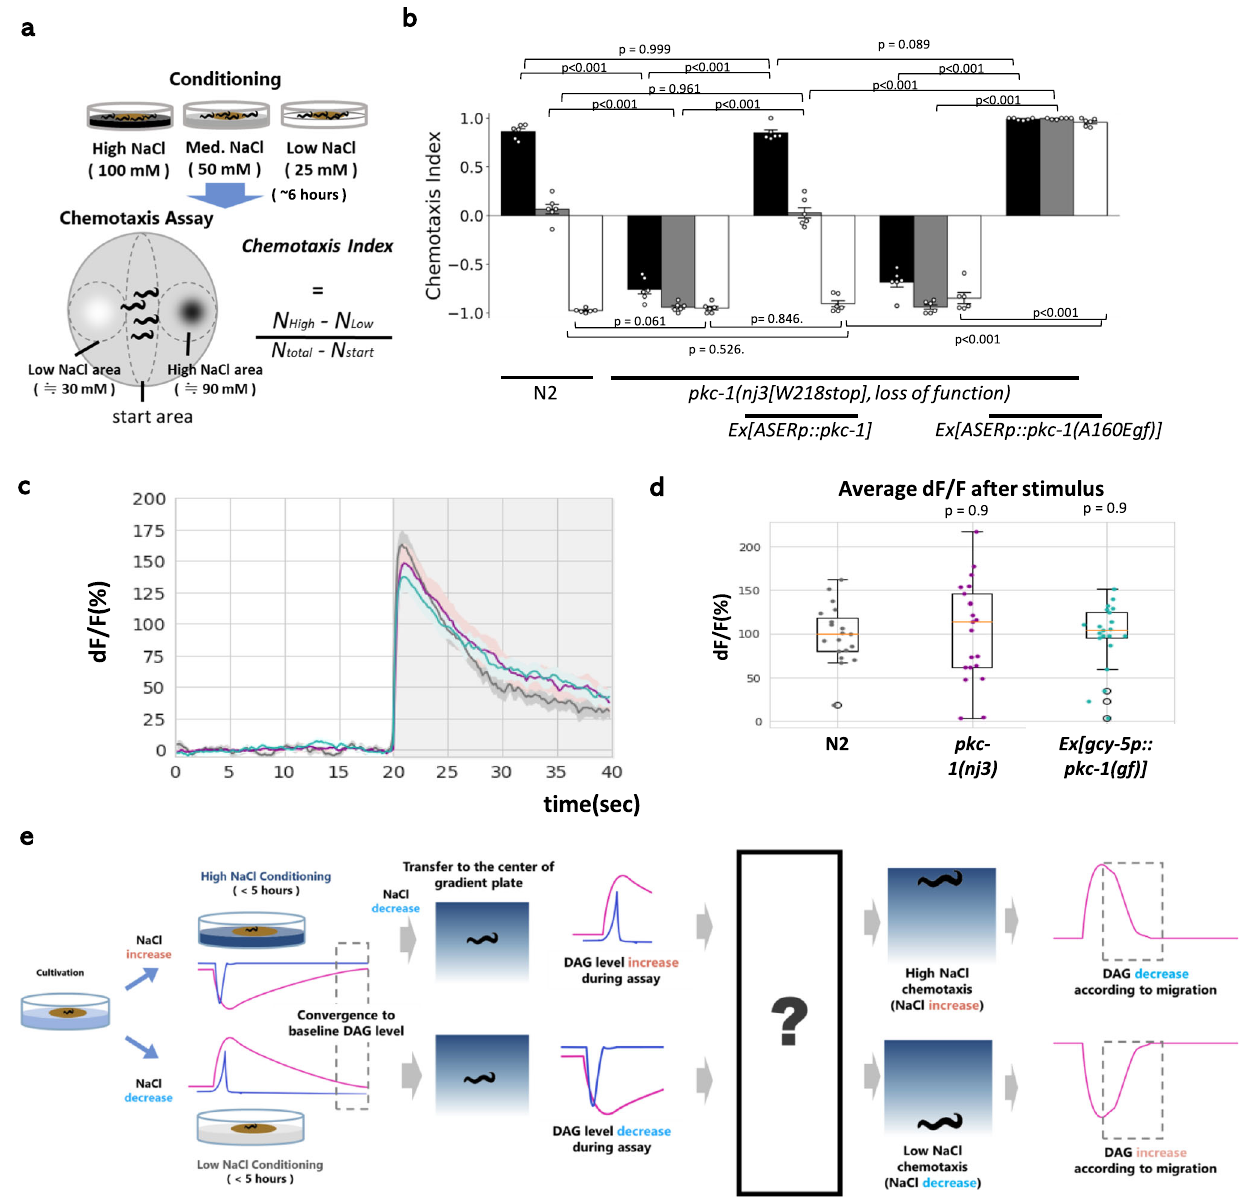
Fig. 1 Activity of PKC-1 in NaCl-sensing neuron ASER controls the navigation toward experienced NaCl concentration. a Schematic illustration of the NaCl concentration-learning paradigm 4 . C. elegans animals are incubated with food at one of the three concentrations of NaCl (100, 50, and 25 mM), and then transferred to an agar plate with gradient of salt concentrations at the start area with ~50 mM of NaCl and allowed to freely migrate. Chemotaxis Index was calculated as indicated based on the numbers of animals in each area at the end of the assay. b Wild-type animals show chemotaxis depending on the NaCl concentration during conditioning, while manipulation of pkc-1 causes altered behaviors showing that PKC-1 functions in the gustatory sensory neuron ASER to determine the direction of migration on the NaCl gradient. n = 6 independent experimental repeats(assays). Error bars indicate SEM. n. s., p > 0.05, *** p < 0.001 in the Tukey ’ s test (multiple comparisons). c Activation of ASER was observed using GCaMP2.1. The NaCl decrease (50 – 25 mM) is indicated with a gray shade. n = 20 independent animals. each color represents the strain: gray: N2, magenta: pkc-1(nj3) , green: Ex[gcy-5p::pkc-1(gf)]. d Quanti fi cation results of ( c ). p values were calculated by Tukey ’ s test. The boxes extend from 25th to 75th percentile ( fi rst and third quartiles), median is marked by the line, and the ends of whiskers indicate the minimum and maximum values within 1.5× the inter-quartile range from the fi rst and third quartiles, respectively. e An illustration of the model of navigation regulated by DAG/PKC 9 . When animals are transferred from growth plates to conditioning plates, following calcium in fl ux or ef fl ux in ASER (blue), the amount of DAG (pink) in ASER either increases or decreases, according to the difference in the concentration of NaCl between the growth plate and the conditioning plate. However, after ample conditioning time, the amount of DAG returns to baseline. When worms are transferred from the conditioning plate to the center of the NaCl gradient, DAG either increases or decreases depending on the difference between the NaCl concentration at the conditioning plate and the center of the gradient plate. Increased or decreased DAG regulates the activity of PKC-1, and PKC-1 signals to unknown molecules to regulate unknown neural processes. Source data are provided as a Source Data fi le.